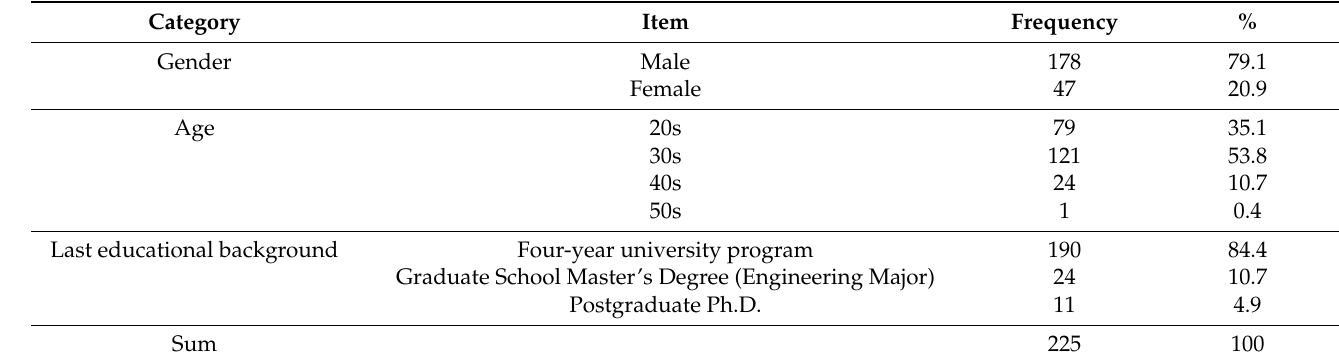
Table 4. Demographic profile for respondents ( N =